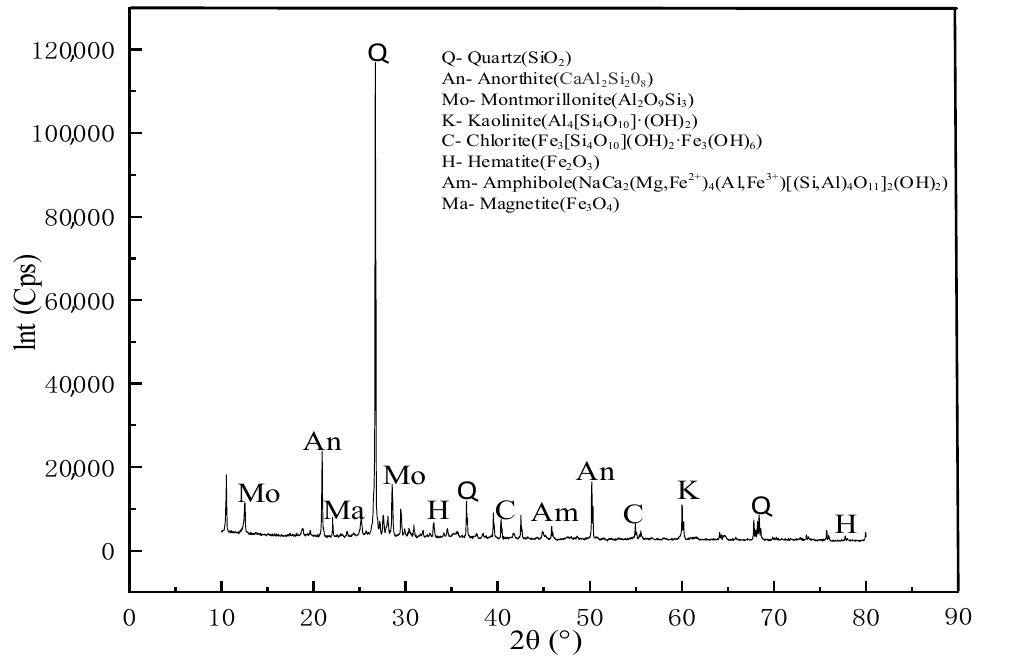
Figure 2. XRD analysis of overflow ultra-fine iron tailings.